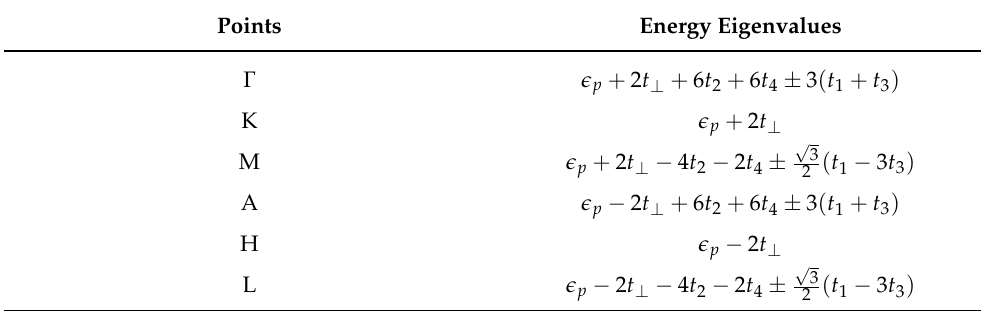
Table 2. The analytical energy eigenvalues at high-symmetry points.